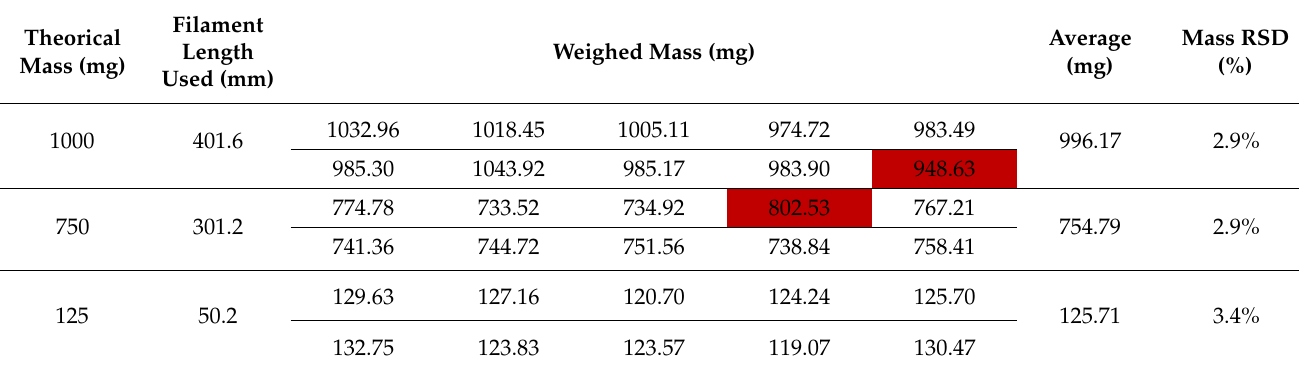
Table 9. Mass uniformity of oral forms produced with formulation B. In red are indicated the oral forms coming out of the 5% mass deviation. All batches comply with the specifications of the European